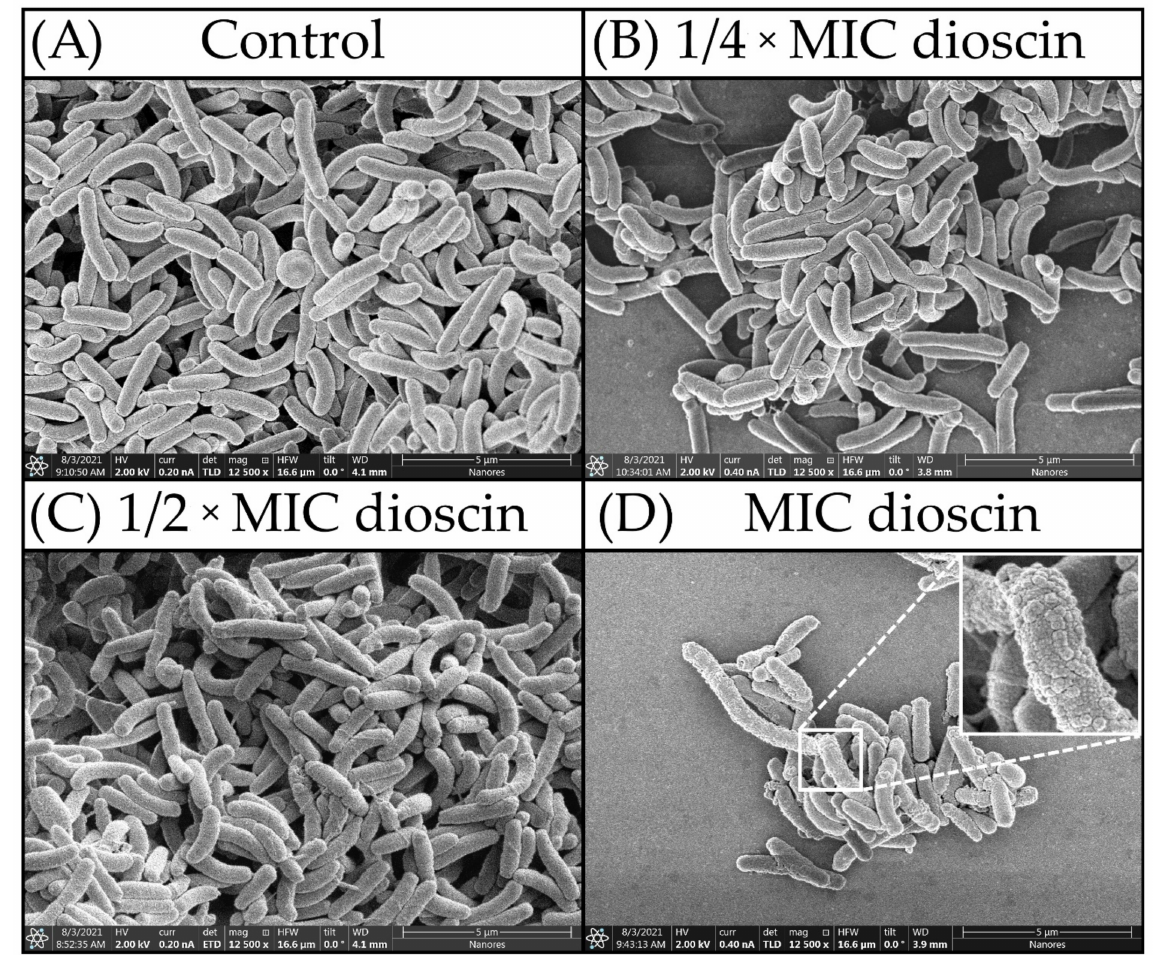
Figure 6. SEM micrographs of H. pylori cells: ( A ) untreated cells (control); ( B ) cells treated × MIC of dioscin; ( C ) cells treated with a 1 with 1 4 MIC of